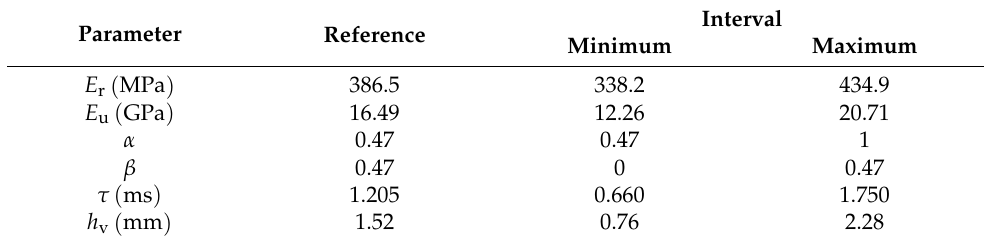
Table 2. Reference value and interval of study for each parameter. Parameter Reference